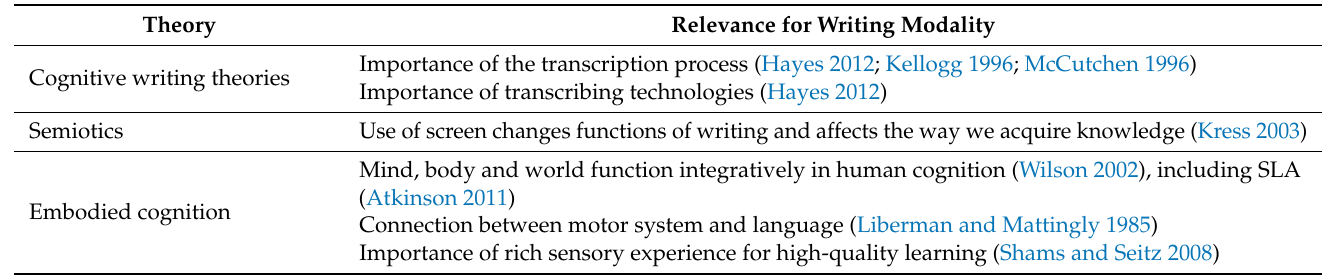
Table 2. Tenets relevant for the theoretical justification of the importance of writing modality in performance and